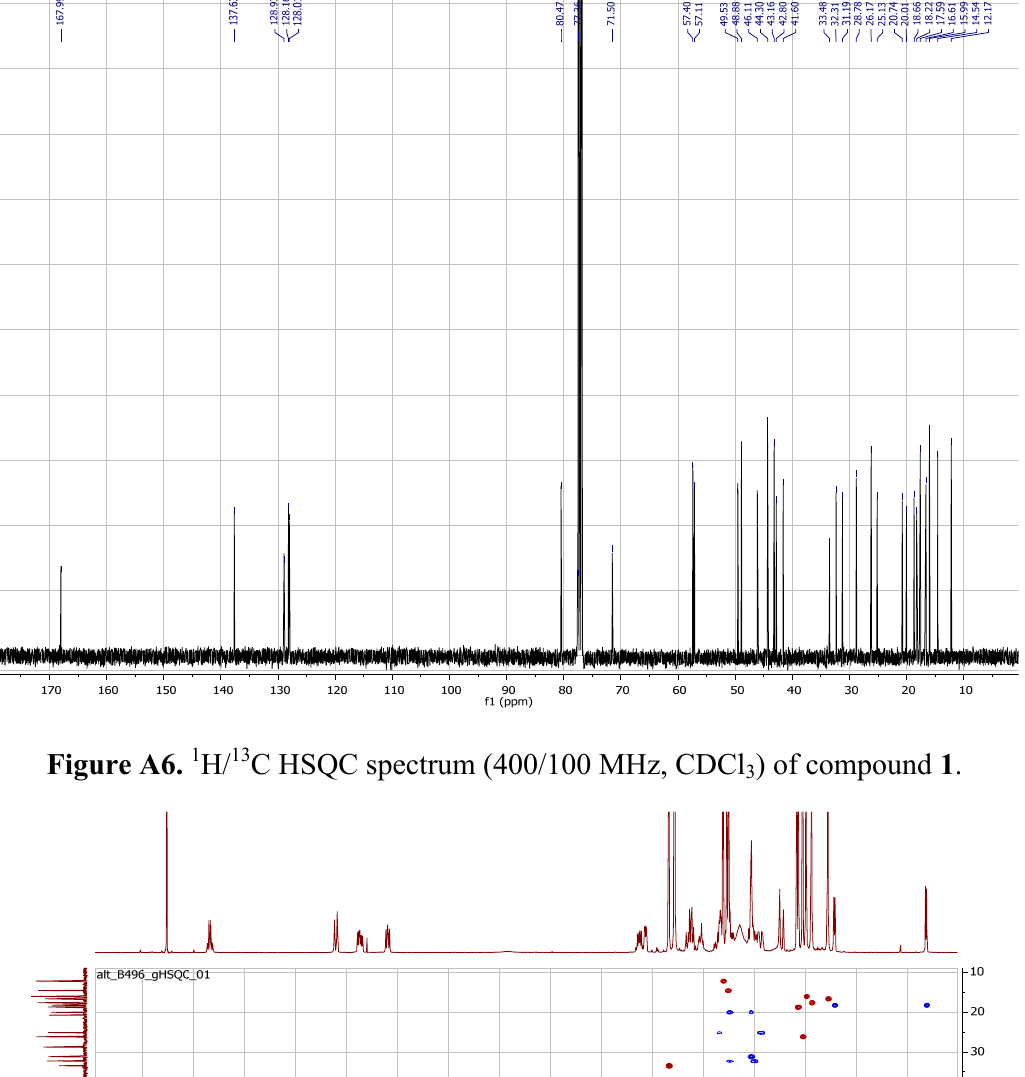
) of compound 1 . 3